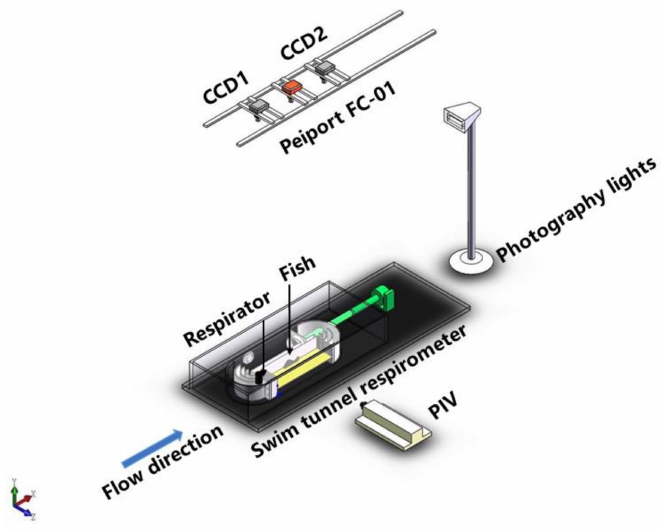
Figure 2. Experimental equipment layout (layout drawings were not drawn to